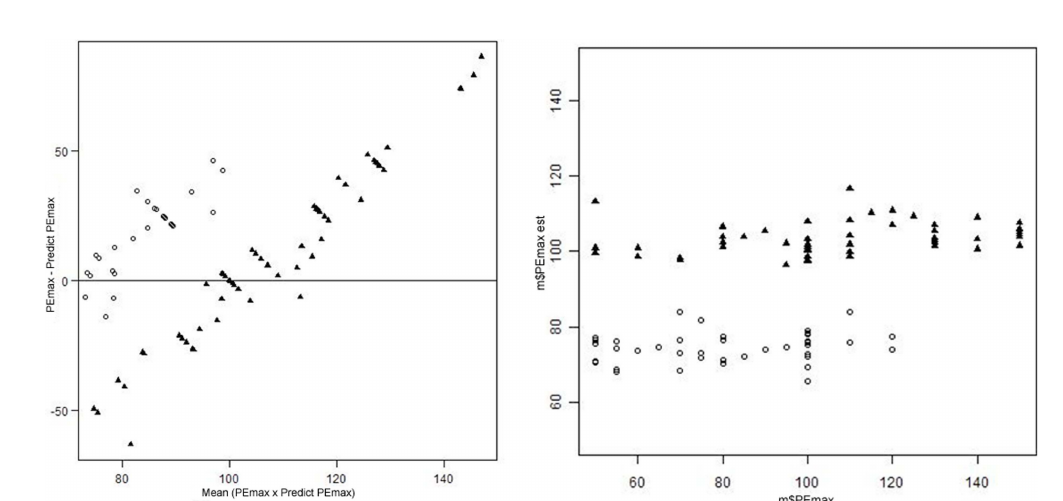
Fig. 8 - Bland-Altman plot and Lin's concordance coefficient of maximal expiratory pressure (MEP) values predicted by the proposed new formula. Confidence interval 95% (0.24 – 0.47); Lin coefficient (0.32); o=female